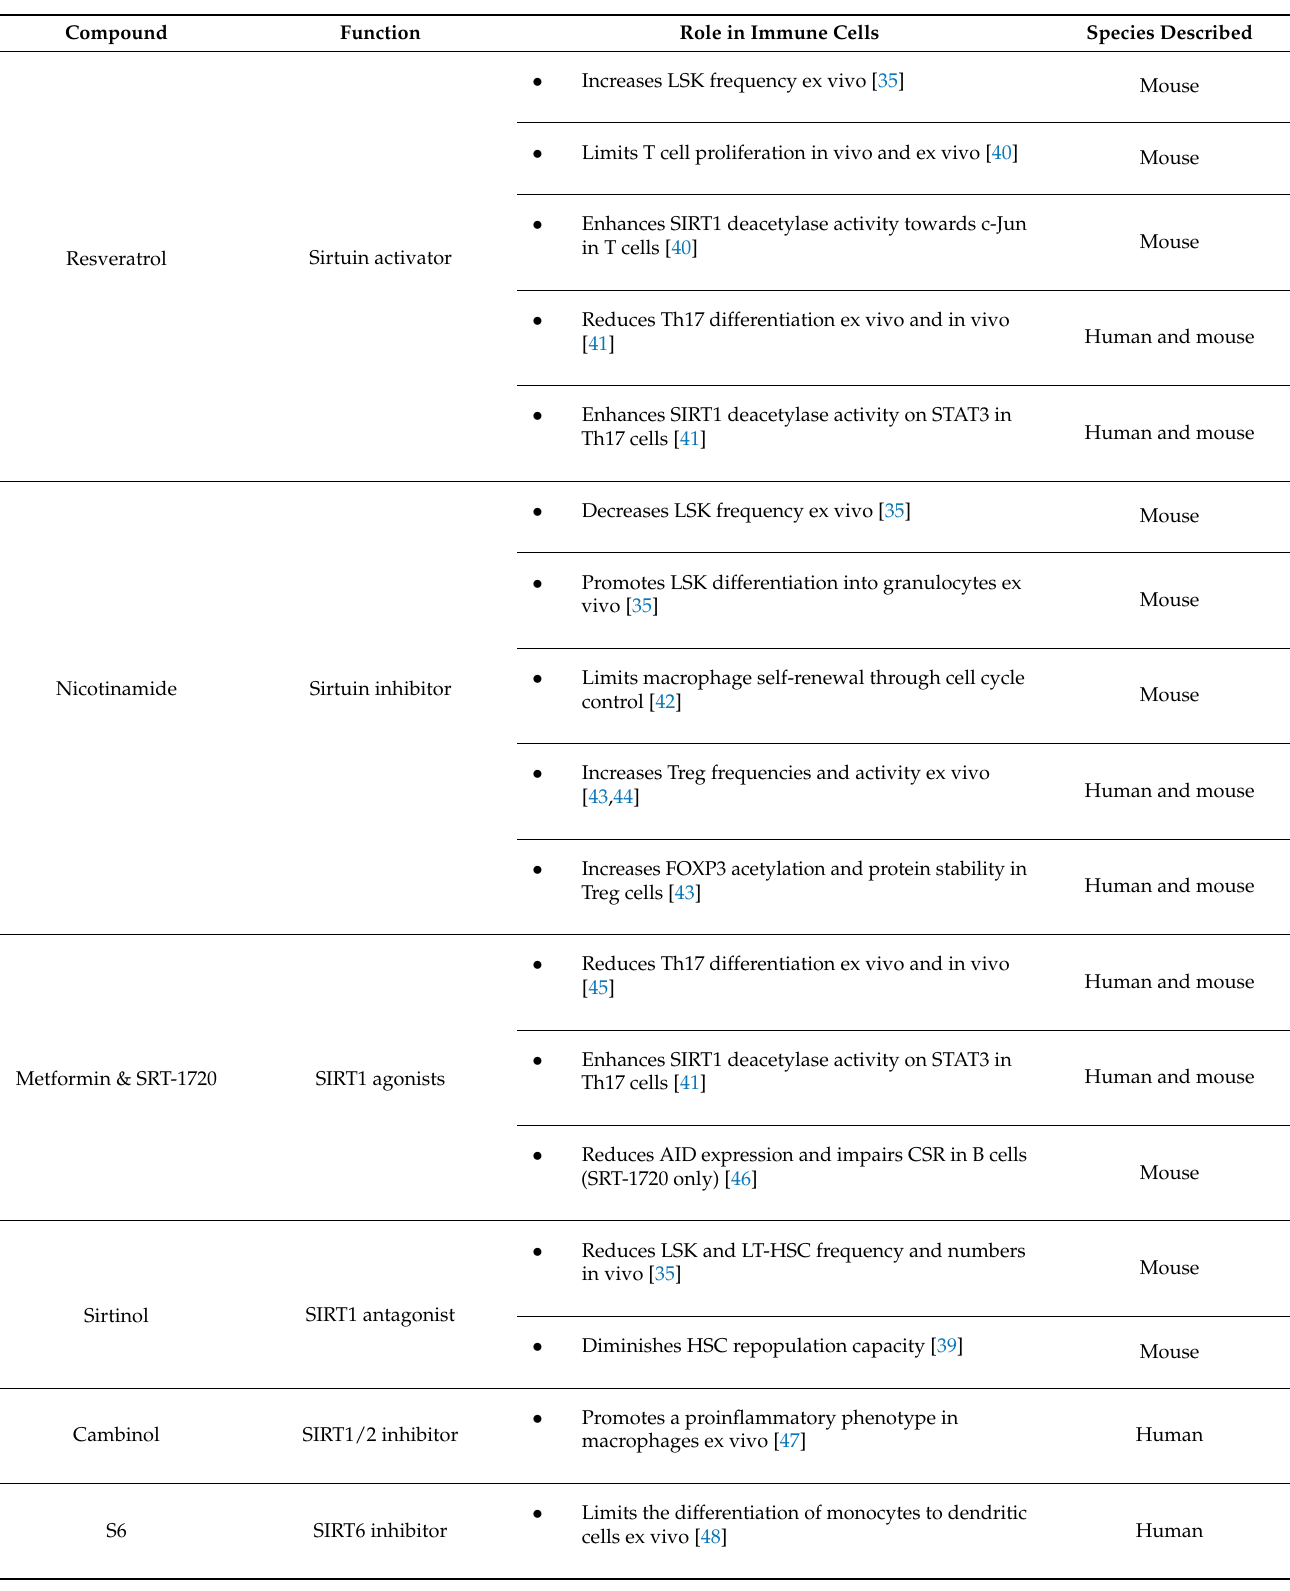
Table 1. Summary of sirtuin-targeting compounds and their effects in immune cell